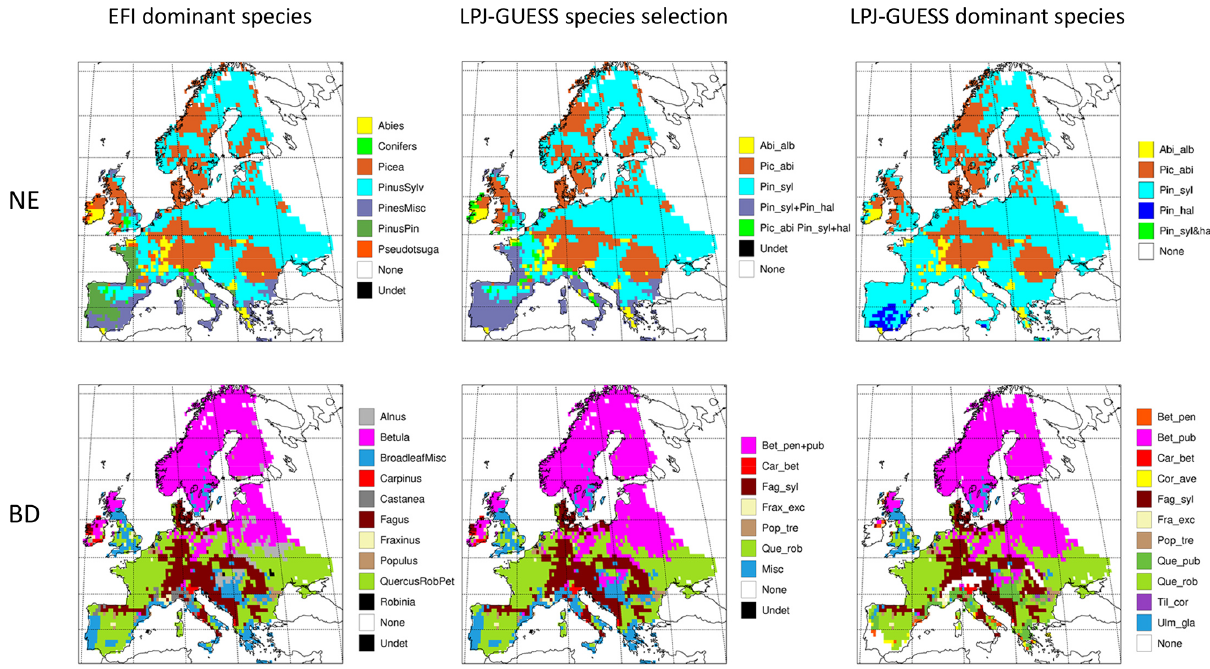
Figure C2. Mapping of dominant EFI tree species groups in the needleleaf evergreen (NE) and broadleaf deciduous (BD) GFAD for- est classes to LPJ-GUESS species selections and the resulting dominant species (LAI) in 1986–2015 in an LPJ-GUESS simulation with automated thinning. Abbreviations of EFI species and species groups are as follows: Abies ( Abies spp.), Alnus ( Alnus spp.), BroadleafMisc (other broadleaves), Betula ( Betula spp.), Carpinus ( Carpinus spp.), Castanea ( Castanea spp.), Conifers (other conifers), Eucalyptus ( Eucalyptus spp.), Fagus ( Fagus spp.). Fraxinus ( Fraxinus spp.), Larix ( Larix spp.), Picea ( Picea spp.), PinusPin ( P. pinaster ), PinusSylv ( P. sylvatica ), PinusMisc ( Pinus spp. other than P. pinaster and P.sylvestris ), Populus ( Populus spp.), Pseudotsuga ( P. men- ziesii ), QuercusRobPet ( Q. robur , Q. petraea ), Robinia ( Robinia spp.). Abbreviations of LPJ-GUESS species and species groups are as follows: Abi_alb ( A.alba ), Pic_abi ( P.abies ), Pin_ syl ( P.sylvestris ), Pin_hal ( P.halipensis ), Pin_ syl + hal ( P.sylvestris + P.halipensis ), Bet_pen ( B.pendula ), Bet_pub ( B.pubescens ), Bet_pen + pub ( B.pendula + B.pubescens), Car_bet ( C.betulus ), Cor_ave ( C.avellana ), Fag_syl